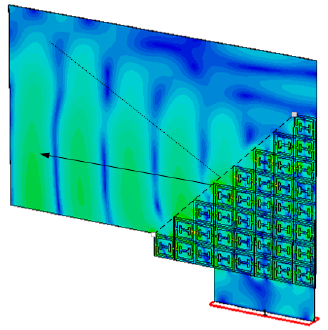
Figure 8. Magnitude of the e-field at 8.8 GHz.